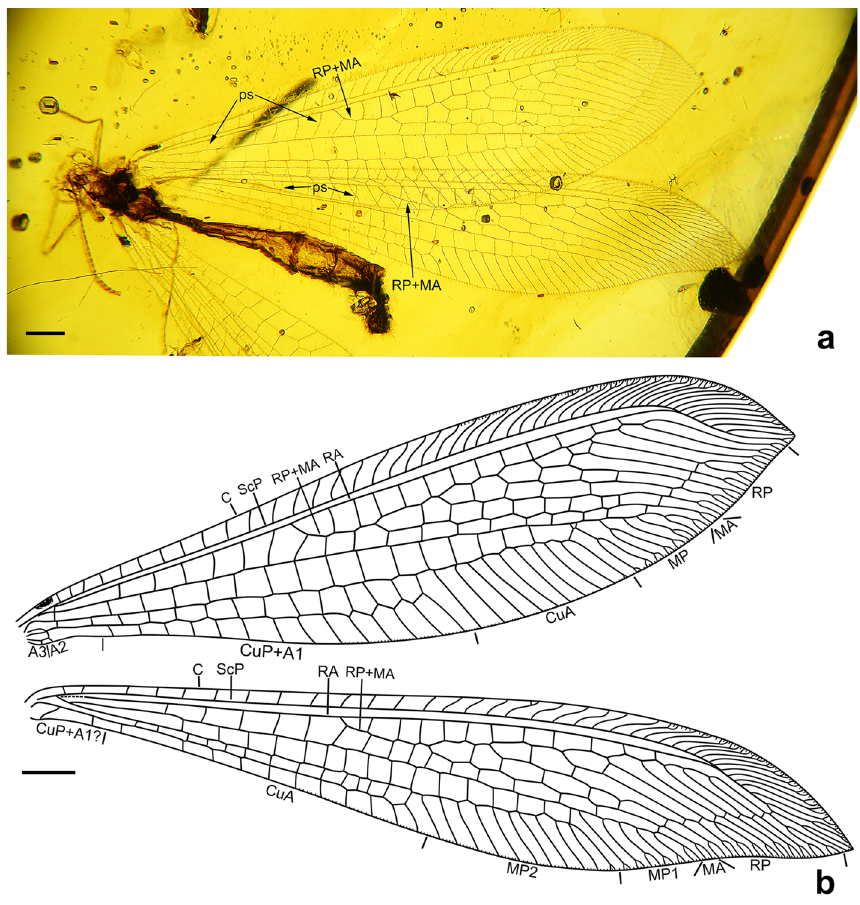
Figure 8. Xiaobabinskaia lepidotricha sp. nov., holotype female. ( a ) photograph of right wings; ( b ) drawing of right wings (drawn by XML). Scale bar = 1.0